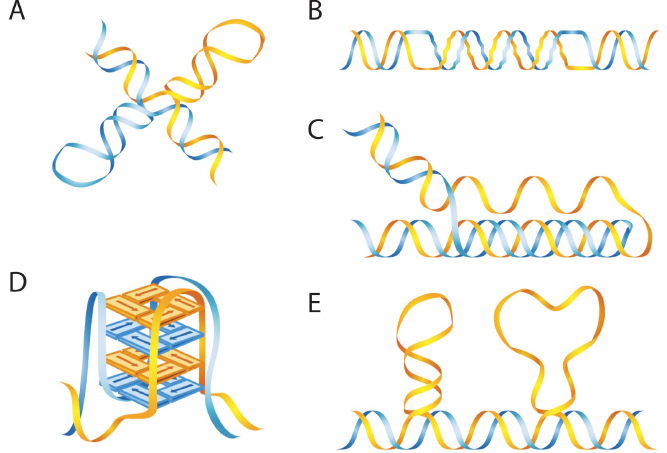
Figure 1. Schematic of several commonly studied non-B DNA structures. ( A ) Cruciform. ( B ) Left-handed Z-DNA. ( C ) Intramolecular triplex H-DNA. ( D ) G-quadruplex/tetraplex. ( E ) Stem-loop ( left ) or bubble ( right ) formed at slipped DNA, (from [24], with permission).